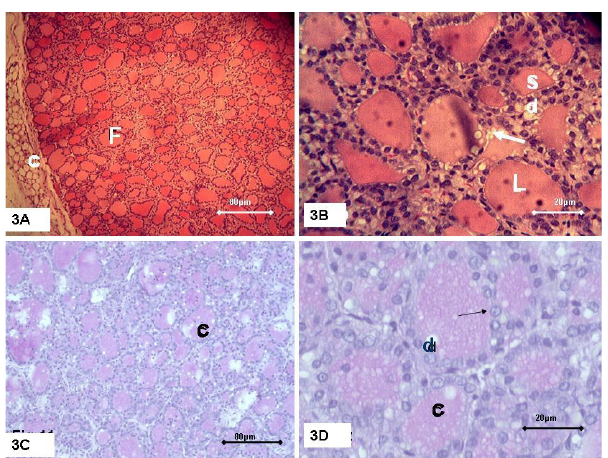
Fig. 4A. Photomicrograph of thyroid prepubertal WADG (2-4 months) goats with several follicles of different sizes with the large follicles (L) appearing more in number and located in the centre of the gland, small follicles (S) are at the periphery with capsule (C). H – E (bar scale 80 μm); Fig. 4B. Photomicrographs of 2-4 months thyroid showing the follicular cells surrounding follicles (F) are cuboidal and columnar in places and Colloid droplets (arrow ) are present on the rim of the colloid. H – E (bar scale 20 μm); Fig. 4C. Photomicrograph showing thyroid of 2-4 months goat showing PAS- positive colloid 0n all follicles. PAS (bar scale 40 μm); Fig. 4D. Sections of 2-4 months goat thyroid at higher magnification showing colloid droplets (d) and follicles (F) surrounded by follicular cells. PAS (bar scale 20